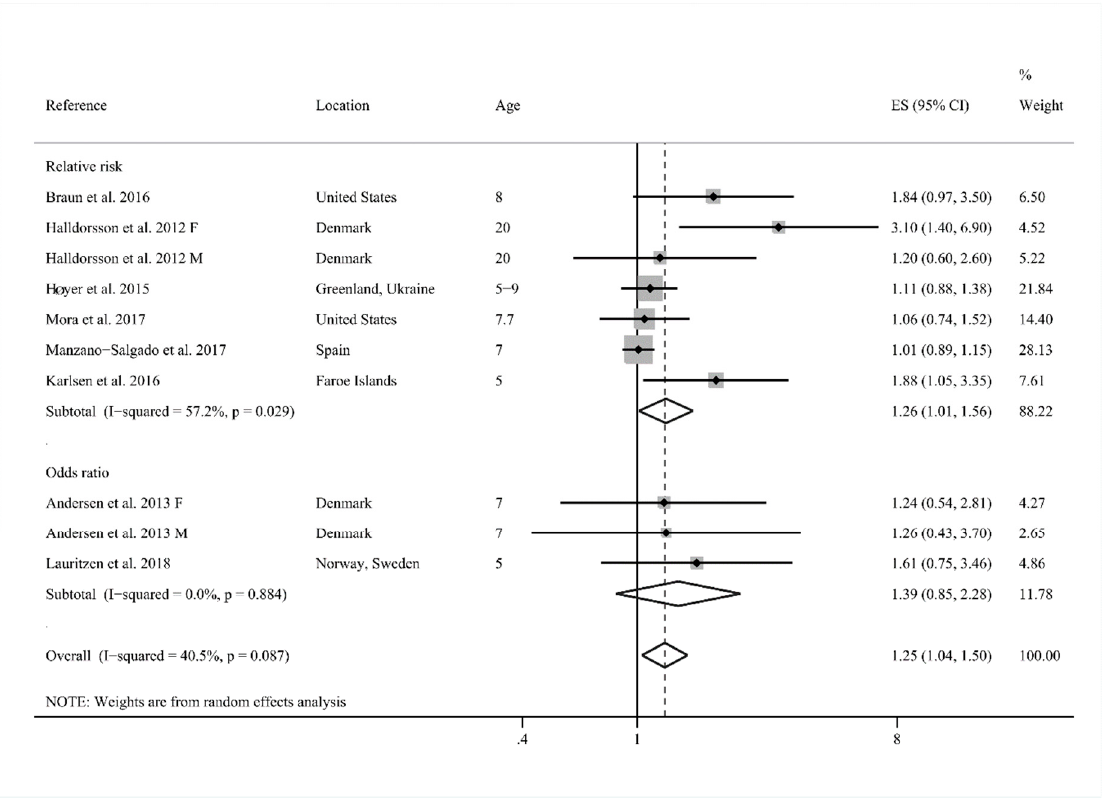
Figure 2. Forest plot of exposure to perfluorooctanoic acid (PFOA) in early life in relation to childhood overweight risk, stratified by effect size (RRs and ORs). ES, effect size; CI: confidence interval; F: females; M: males.